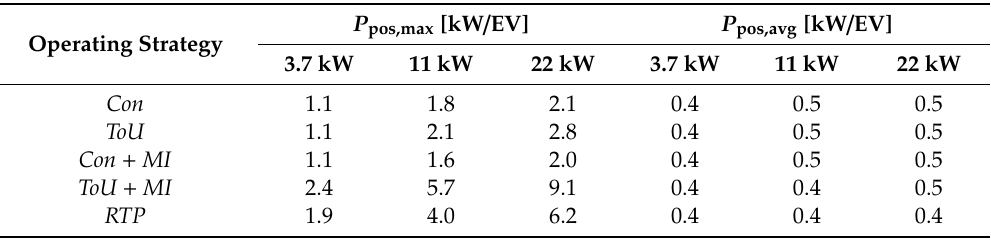
Table 5. Maximum and average positive flexible power for five operating strategies and three maximum charging powers.